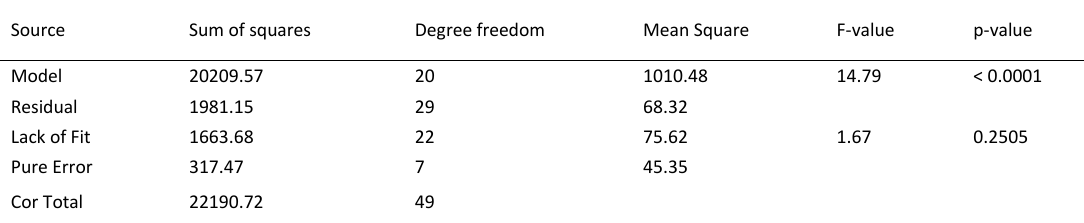
Table 3. ANOVA for the second-order model of CIP removal by BFO from CCD based on RSM method Source Sum of squares